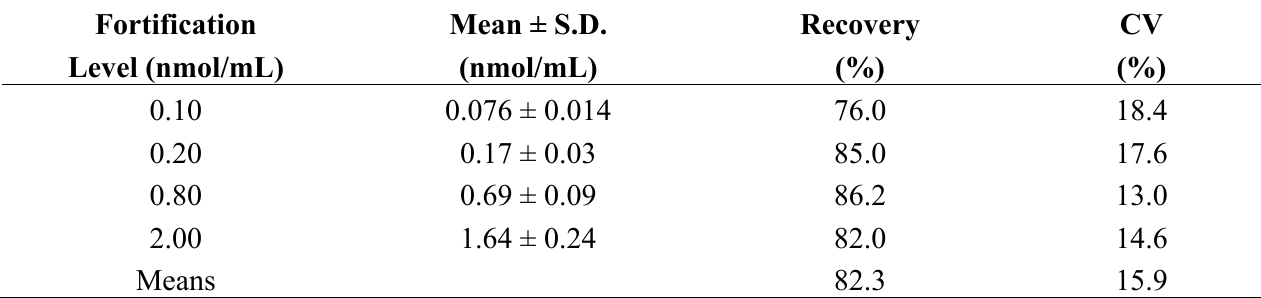
Table 3. Analysis of DNSH present in chicken tissues by indirect ELISA